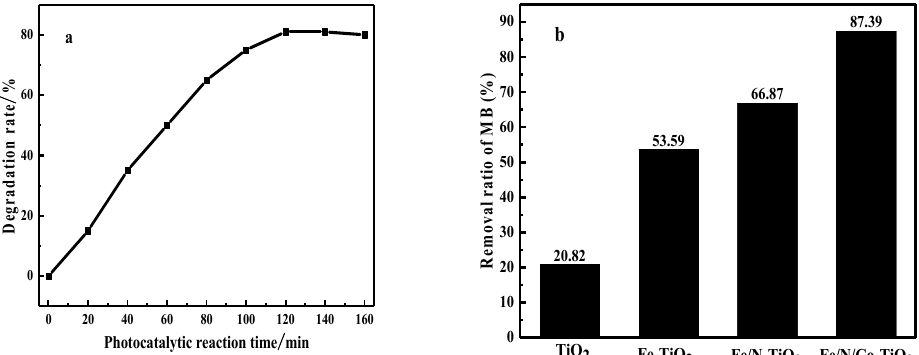
Figure 8. Methylene blue (MB) degradation experiment. ( a ) The variation of MB degradation efficiency with reaction time; ( b ) degradation rates for MB after 120 min under visible light irradiation.